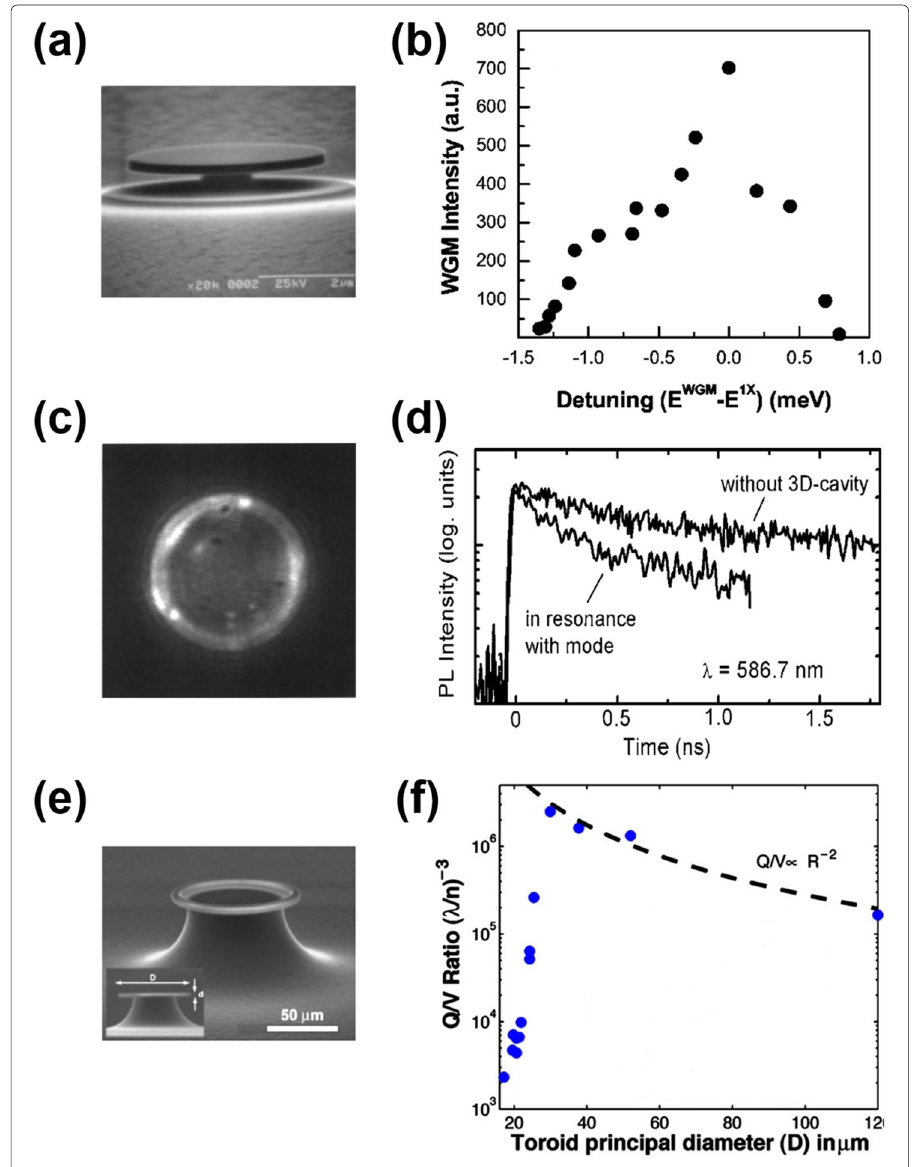
Fig. 3 SE based on WGM structures. a The microdisk structure containing a single InAs quantum dot [84]. b Enhancement of spontaneous emission when WGM and exciton are on resonance [10]. c A glass microsphere doped with CdSe nanocrystals in a thin surface shell [89]. d The radiative lifetime of CdSe quantum dots with and without WGM structure [89]. e A high Q / V toroid microcavity on a chip [11]. f Measured Q / V ratio of toroid microcavities by varying principal diameter D [11]